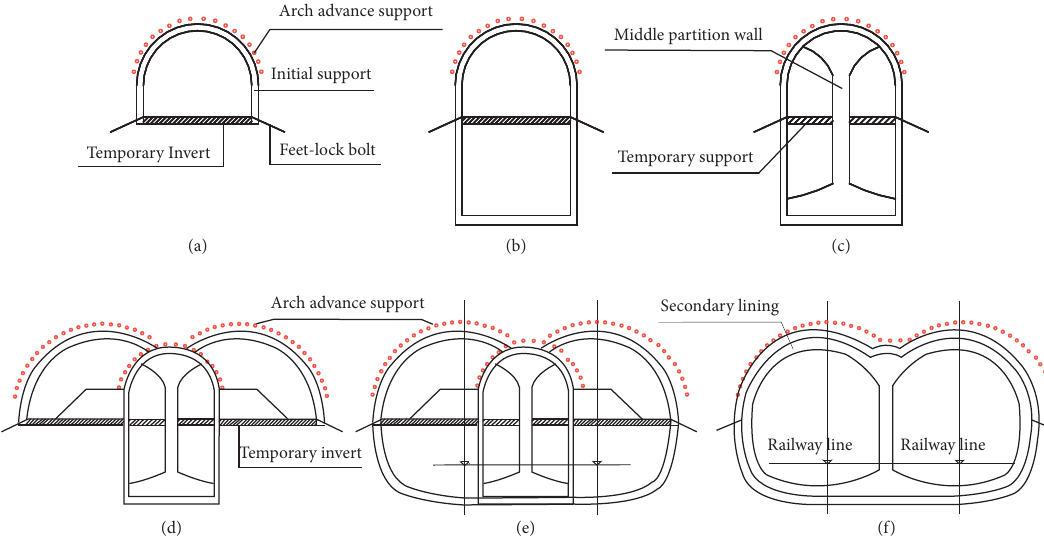
Figure 6: Construction steps of concealed excavation. (a) Excavation of middle drift (upper). (b) Excavation of middle drift (lower). (c) Construction of middle partition wall. (d) Excavation of side drift (upper). (e) Excavation of side drift (lower). (f) Construction of side drift waterproof layer and secondary